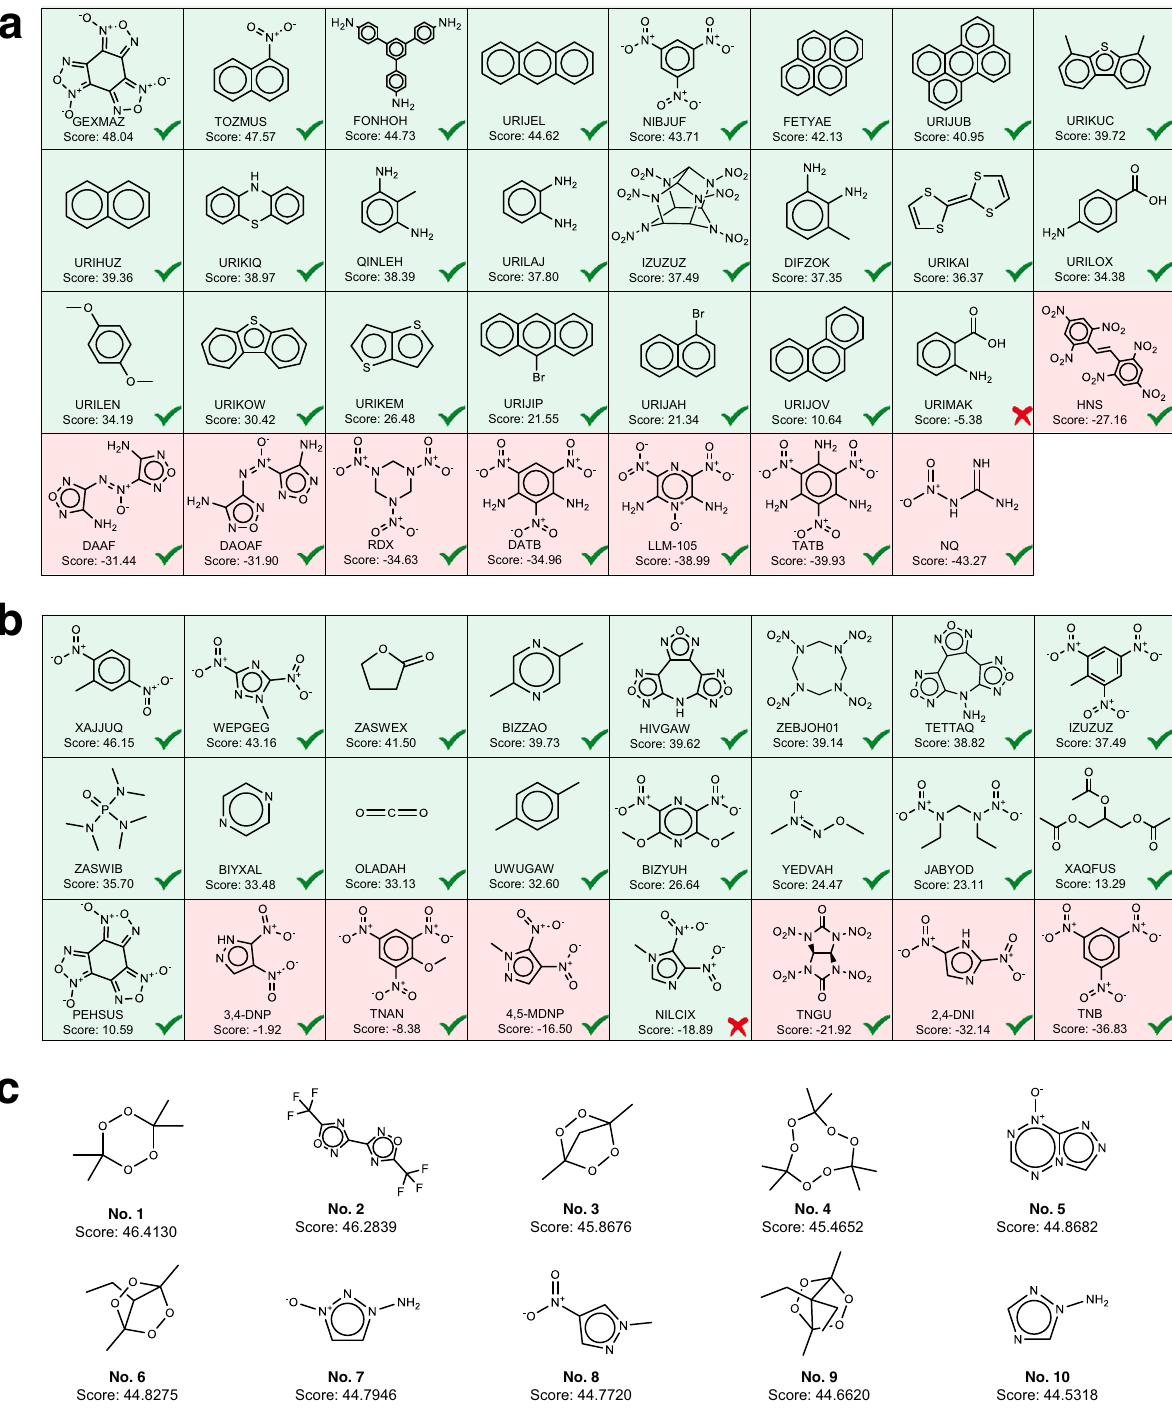
Fig. 6 Score ranking predicted for the independent testing set of the energetic cocrystals. a Coformers of TNT. b Coformers of CL-20. c Structures of top ten coformers screened for CL-20. The green and red backgrounds indicate the true positive sample and true negative sample, respectively. The green tick denotes the correct prediction of the model while the red cross represents the wrong prediction. The score higher, the more likely to crystallize with 4 , 6 , and 9 ) in the subsequent experiment on co-crystalization 6 , and 9 ), one fl uorides (coformer 2 ), one triazole derivatives with CL-20. For the remaining coformers 5 , 7 , 8 and 10 , we (coformer 10 ) and three energetic molecules only containing C, calculate their impact sensitivities and explosion heats that are H, O, and N atoms (coformers 5 , 7 , 8 ). Considering usually high two important properties involving the safety and the explosion sensitivity of the peroxides 73,74 and the requirement to environ- performance. The calculation methods are described in Supple- mental safety for modern explosives 75,76 . we fi rst exclude the six mentary Methods and the calculated results are listed in coformers involving the peroxides and fl uorides (cofomers 1 , 2 , 3 ,